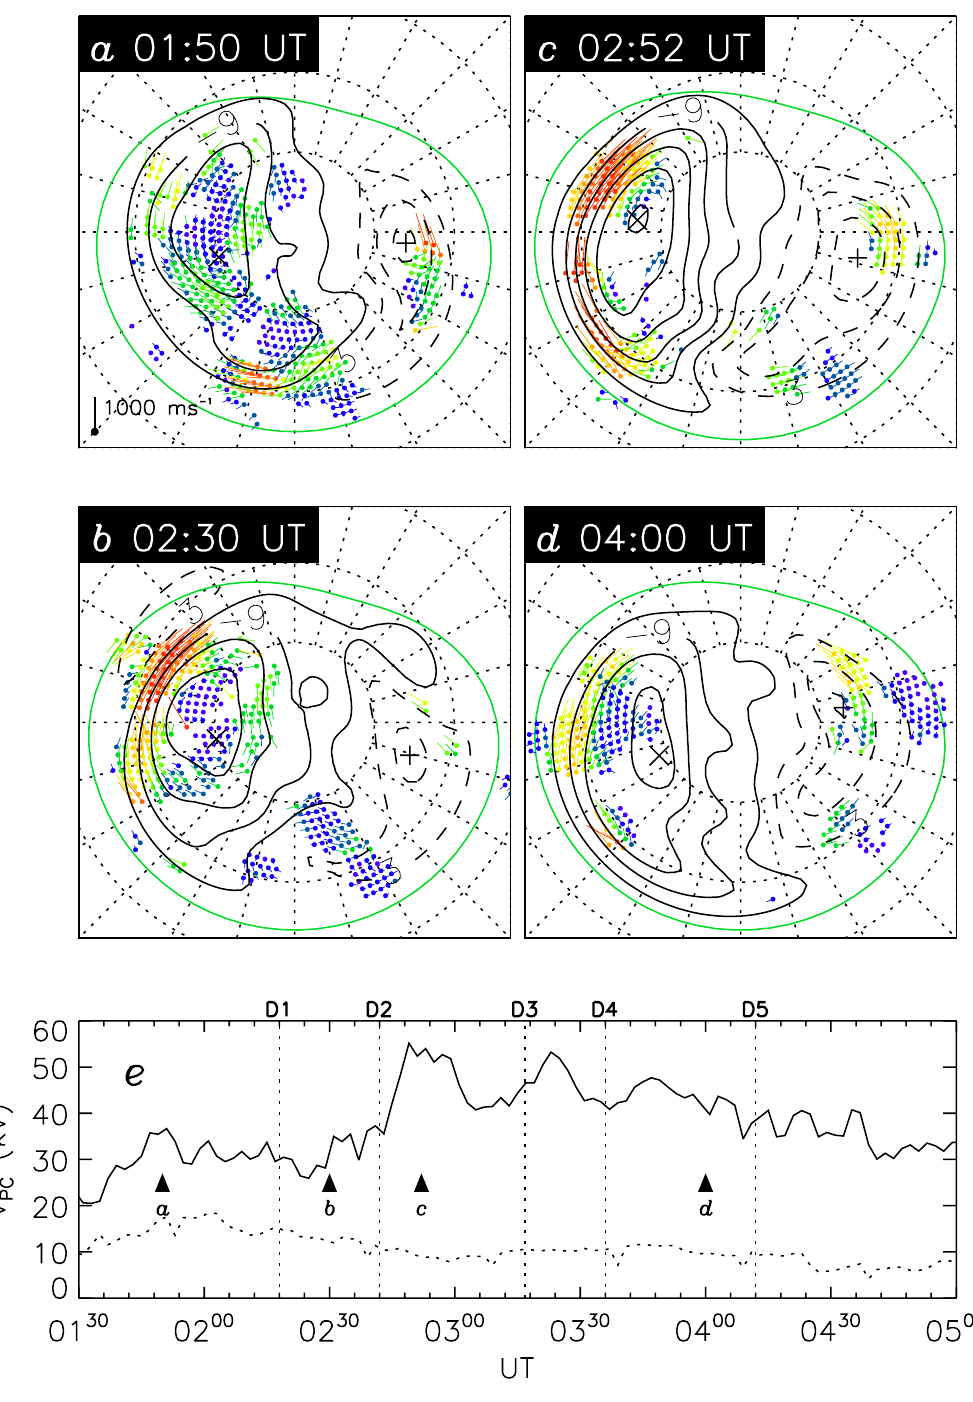
Fig. 8. (a)–(d) Selected convection maps derived by the SuperDARN network, shown in a magnetic latitude and MLT frame. Contours of electrostatic potential are separated by intervals of 6kV. (e) The time series of cross-polar cap potential 8 PC derived from the SuperDARN observations (solid curve); the dotted curve gives an indication (on an arbitarty scale) of the number of data points that contribute to each map, showing that there are no sudden appearances or disappearances of regions of